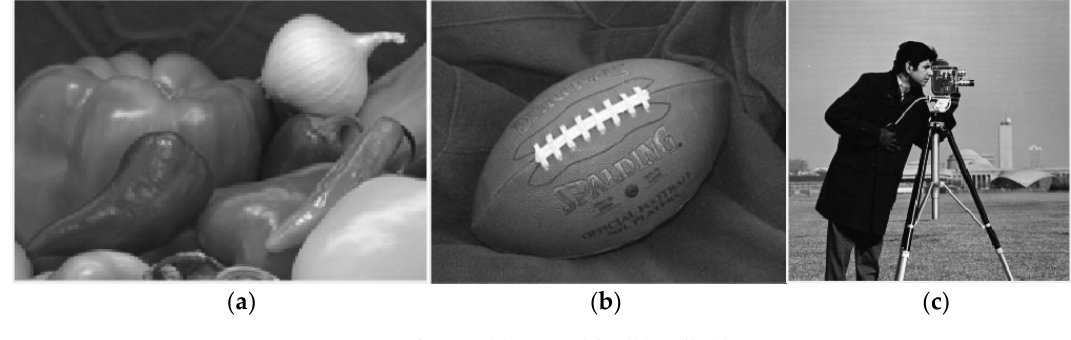
Figure 9. Test objects: ( a ) Vegetable; ( b ) Ball; ( c )